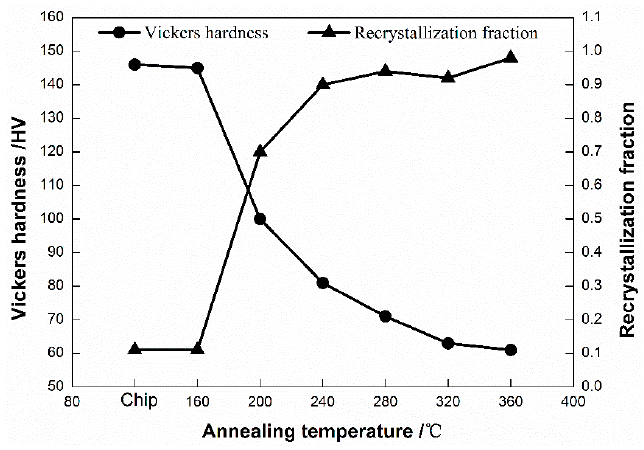
Figure 8. Vickers hardness values and recrystallization fractions at different annealing temperatures.